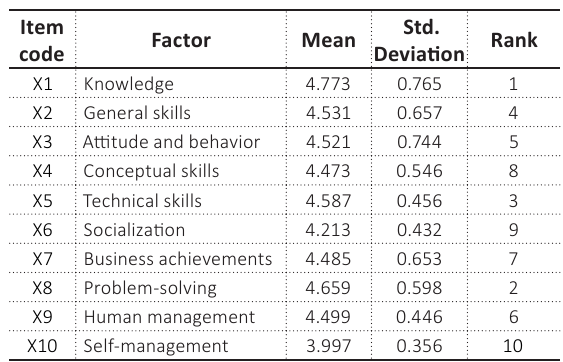
Table 3. Ranking the mean values for each